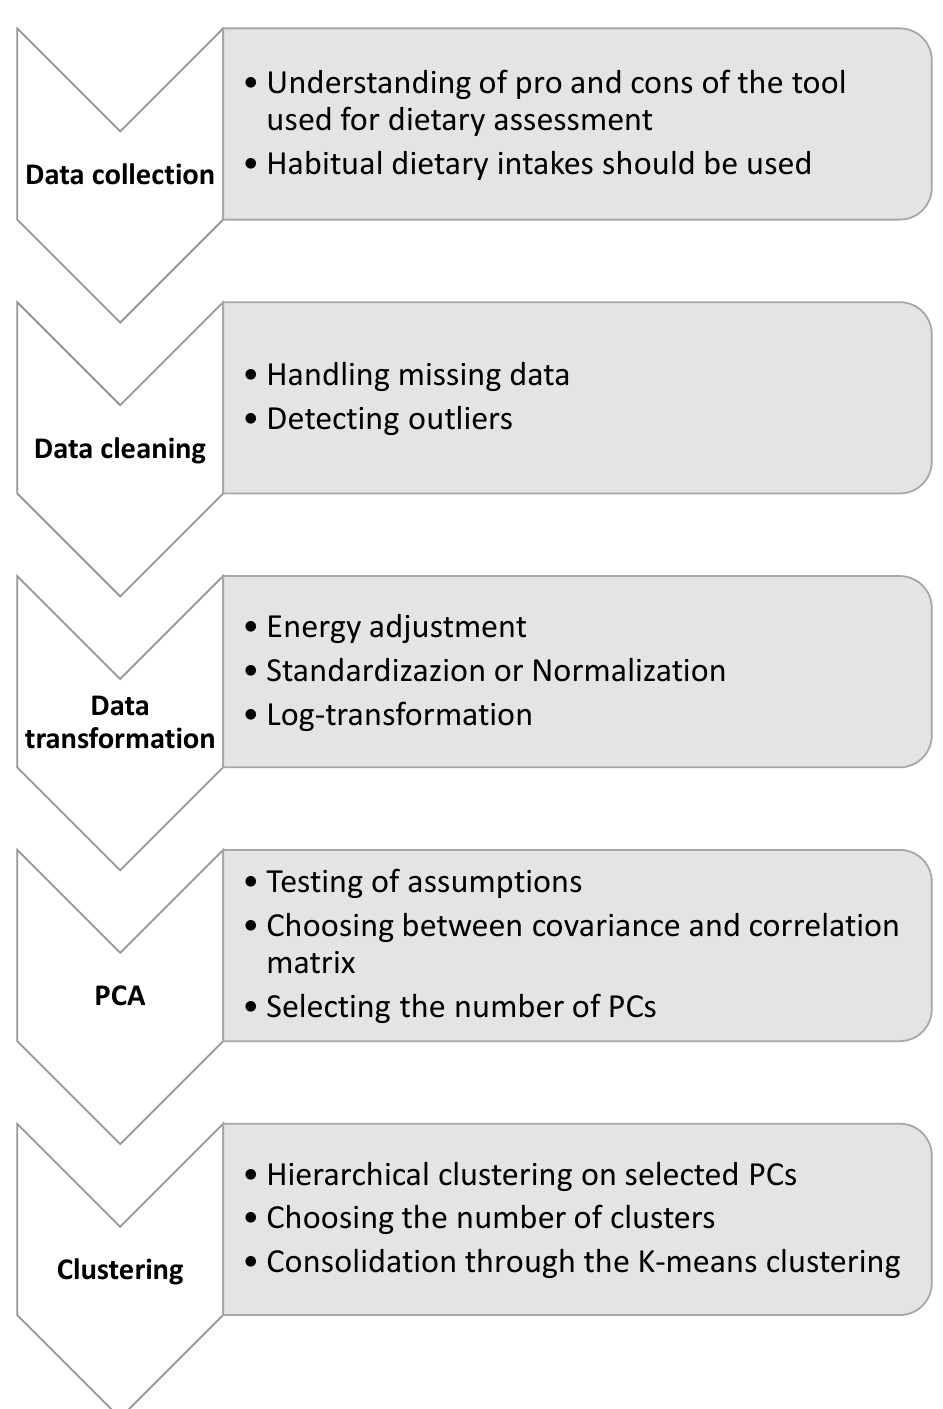
Figure 1. Workflow of the clustering on principal components to derive dietary patterns. The flow chart summarizes the steps of this approach, from data collection to clustering and consolidation. For each step, objectives and potential alternatives are reported. Abbreviations: PCA, principal component analysis; PCs, principal components.